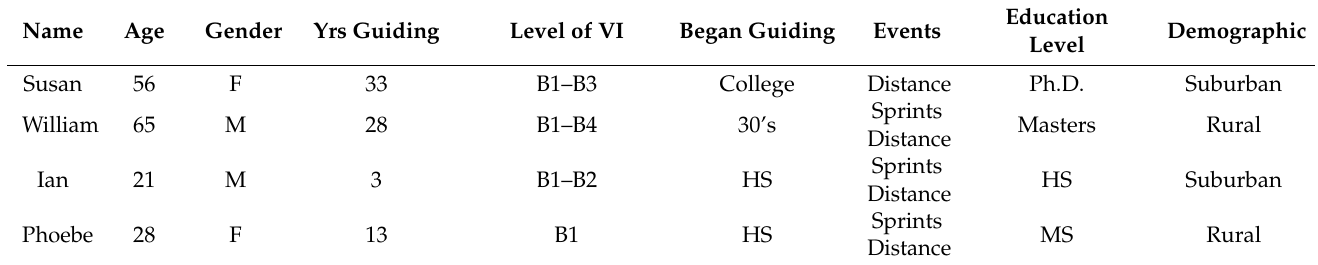
Table 2. 0 Demographic information of the